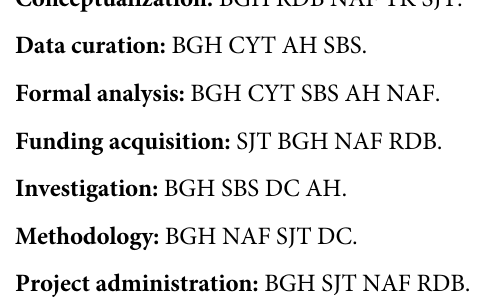
S1 Table. Delta Smelt collection. Sites where Delta Smelt were collected (n = 1,318), sample size (number of Delta Smelt collected), mean salinity (psu), mean temperature (˚C), mean tur- bidity (NTU), and sampling site latitude and longitude. Standard deviations are in parenthe-